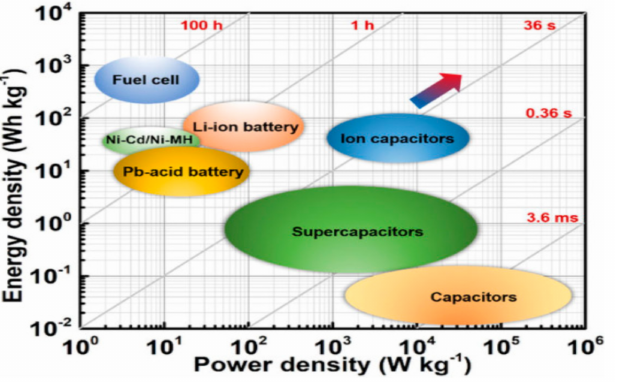
Figure 8. The comparison of energy density and power density for different energy storage devices.